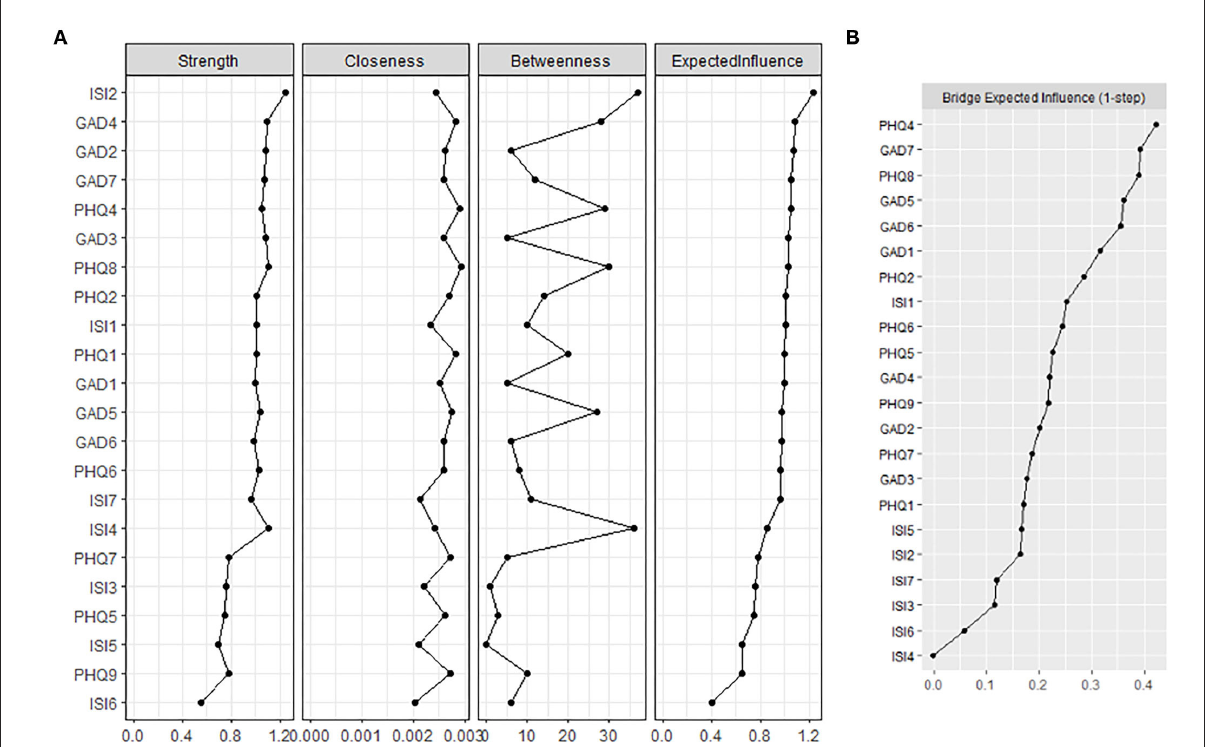
FIGURE2 Centrality index and bridge expected influence of the nodes. (A) Centrality index of the nodes within the network. Higher expected influence suggested being more influential. (B) Bridge expected influence of the nodes. Nodes with higher bridge expected influence were considered to be the bridge symptoms which drove the